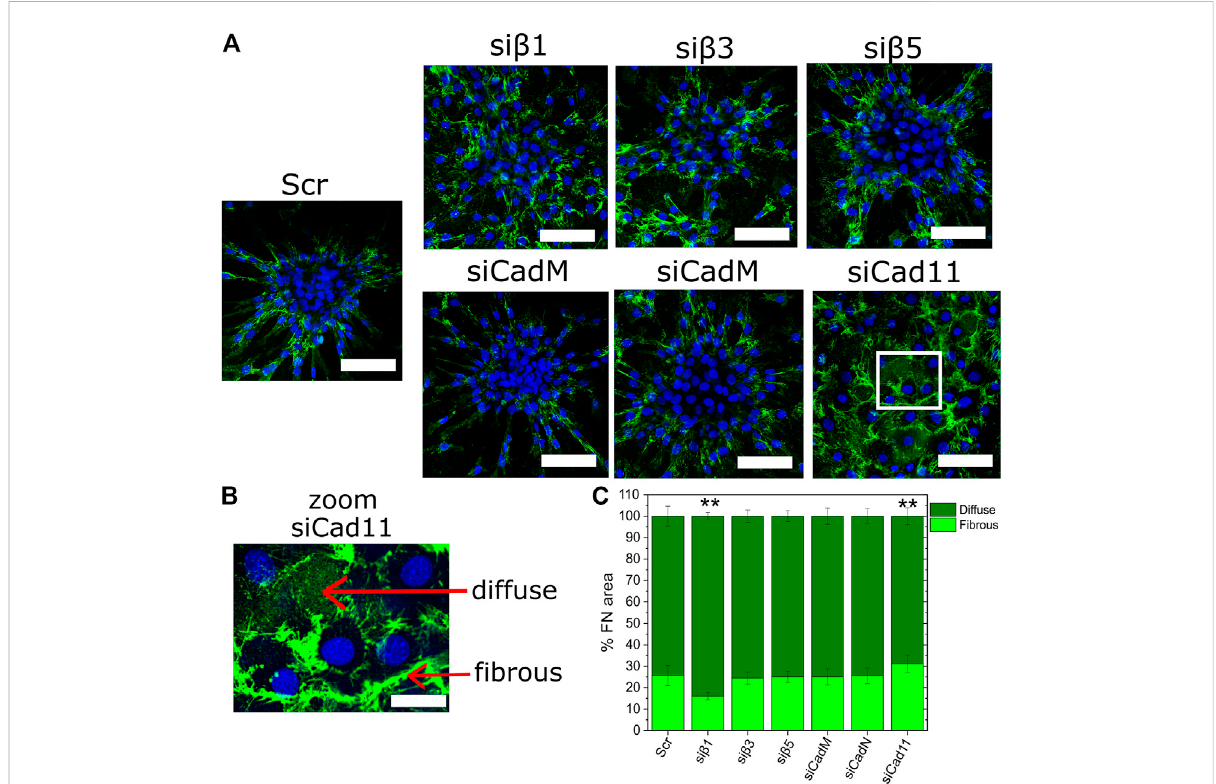
FIGURE 8 BMP-2-induced fi bronectin remodeling depends on ITGB1 and cad-11. (A) Microscopic observations of fi bronectin network after silencing usingRNAofITGB1,3,5andM-cad,N-cad,cad-11(sameasinFigures6,7).Fibronectin(green)andactin(blue)werestainedbyimmuno fl uorescence after 4 days (24 h in GM and 3 days in DM) of C2C12 cell cultured on fi lms with matrix-bound BMP-2. (A) Representative image of each of the silencing condition. Scale bar are 50 µm. (B) Zoom on two conditions: silencing of β 1 integrins and cadherin 11. Scale bar is 20 µm. (C) Quanti fi cation of the areal fraction of diffuse and fi brous fi bronectin given: the total is set to 100 and the fraction represents the importance of each population. Data are mean ± SD of three independent experiments. Statistical tests were done using non-parametric Kruskal – Wallis ANOVA (* p < 0.05; ** p <